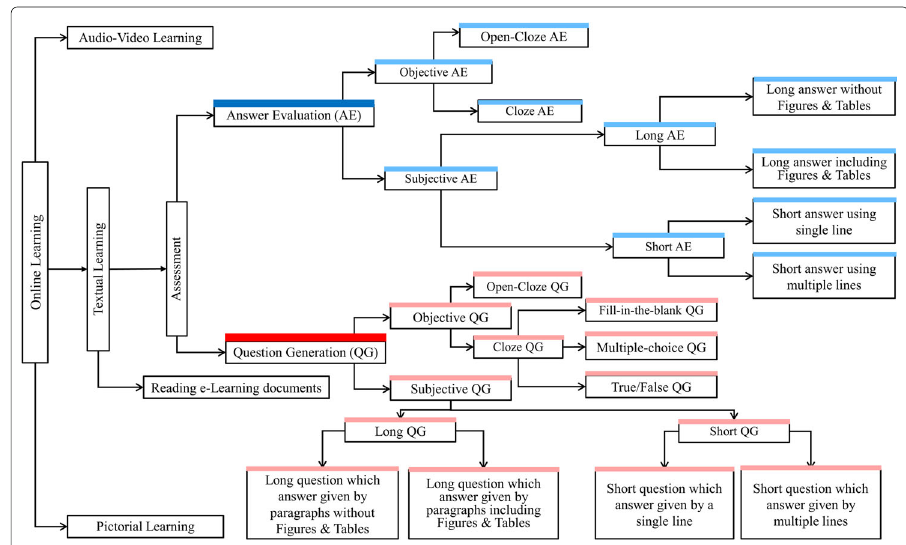
Fig. 1 Different modalities of question generation and assessment methods reported in